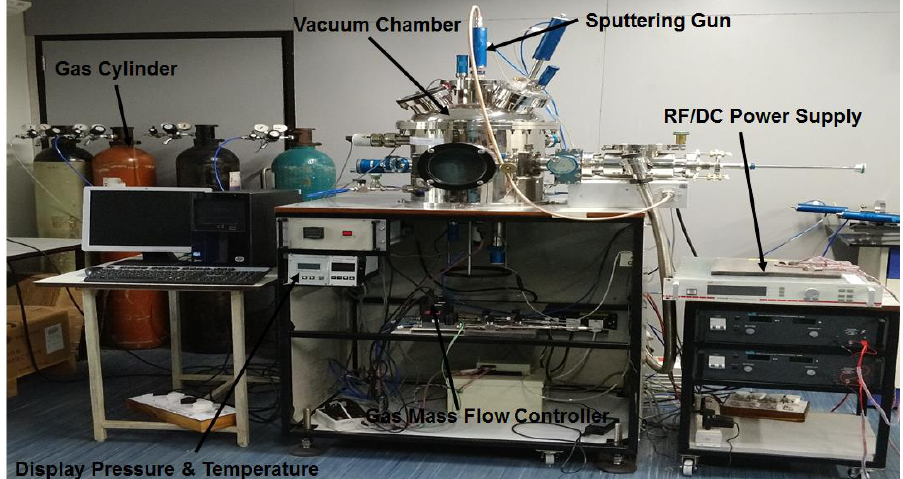
Figure 2. Magnetron sputtering setup. Table 4. The process parameters for PVD coating.